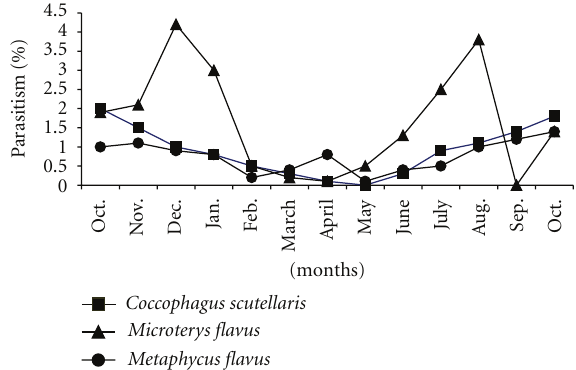
Figure 2: Percent parasitism of Coccophagus scutellaris and other associated parasitoidsof Ceroplastes floridensis on citrus in Gharbiya governorate before releasing during